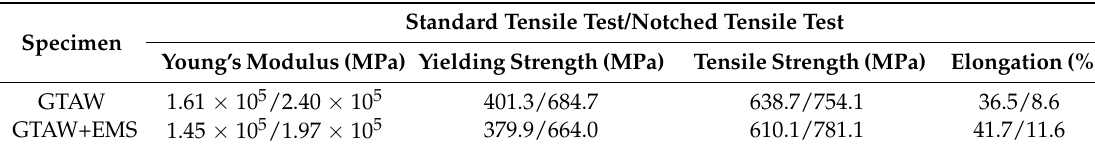
Figure 14. The stress-strain curves for the tensile tests on the CASS weldments at room temperature. Table 7. The tensile test results of the CASS weldments at room temperature.